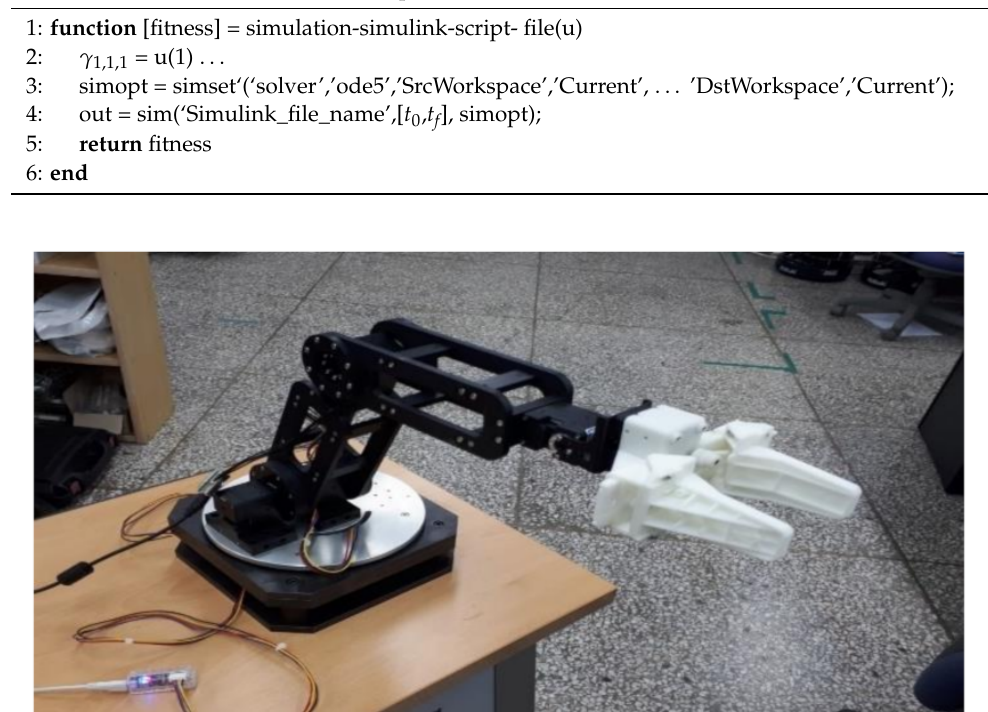
Algorithm 2 simulation-simulink-script-file code